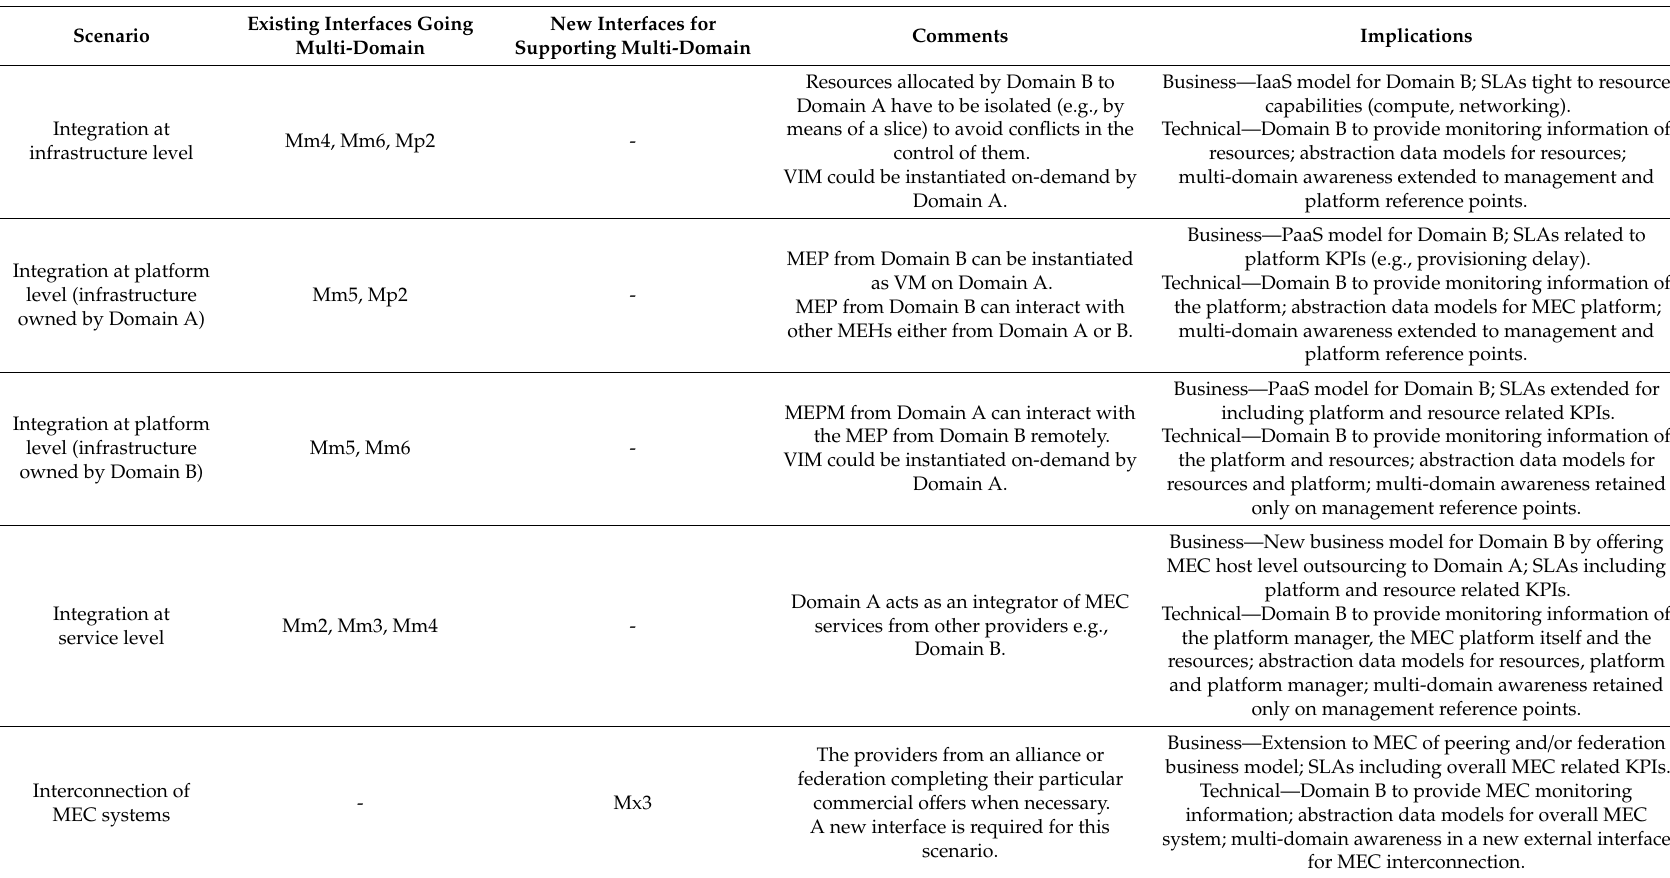
Table 3. Summary of multi-domain integration